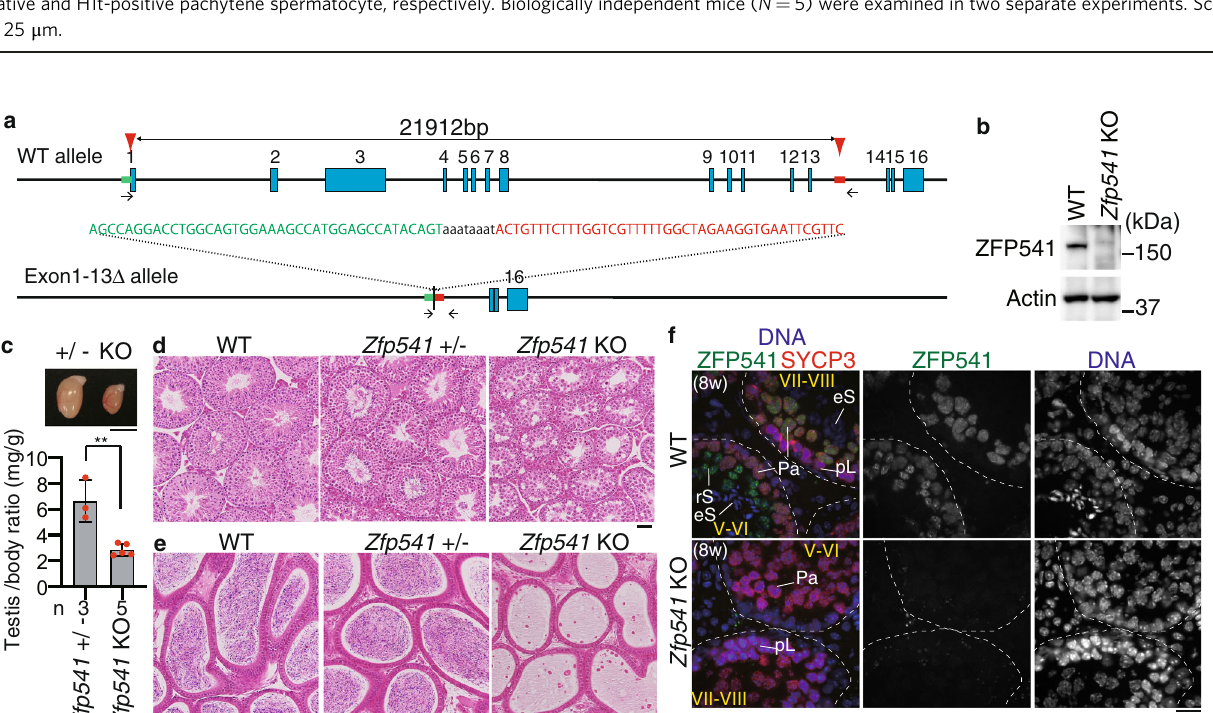
Fig. 2 Spermatogenesis was impaired in Zfp541 knockout male. a The allele with targeted deletion of Exon1 – 13 in Zfp541 gene was generated by the introduction of CAS9, the synthetic gRNAs designed to target Exon1 and the downstream of Exon13 (arrowheads), and ssODN into C57BL/6 fertilized eggs. Arrows: PCR primers for genotyping. Four lines of KO mice were established. Line #16 of Zfp541 KO mice was used in most of the experiments, unless otherwise stated. b Immunoblot analysis of testis extracts prepared from mice with the indicated genotypes (P21). Biologically independent mice ( N = 2) were examined in two separate experiments. c Testes from Zfp541 ± and Zfp541 KO (8-weeks old). Testis/body-weight ratio (mg/g) of Zfp541 ± and Zfp541 KO mice (8-weeks old) is shown below (mean with SD). n : the number of animals examined. Statistical signi fi cance is shown by ** p = 0.0021 (two-tailed t -test). Scale bar: 5 mm. d Hematoxylin and eosin staining of the sections from WT, Zfp541 ±, and Zfp541 KO testes (8-weeks old). Biologically independent mice ( N = 3) for each genotype were examined. Scale bar: 50 μ m. e Hematoxylin and eosin staining of the sections from WT, Zfp541 ±, and Zfp541 KO epididymis (8-weeks old). Biologically independent mice ( N = 3) for each genotype were examined. Scale bar: 50 μ m. f Seminiferous tubule sections (8-weeks old) were stained for SYCP3, ZFP541, and DAPI. pL: preleptotene, Pa: pachytene spermatocyte, rS: round spermatid, eS: elongated spermatid. Boundaries of the seminiferous tubules are indicated by white dashed lines. Roman numbers indicate the seminiferous tubule stages. Biologically independent mice ( N = 3) for each genotype were examined. Scale bars: 15 μ Zfp541 KO seminiferous tubules (Fig. 2d, f). Accordingly, sperm was absent in Zfp541 KO caudal epididymis (Fig. 2e). Con- sistently, seminiferous tubules that contain PNA lectin (a mar- ker of spermatids)-positive cells were absent in Zfp541 KO (Supplementary Fig. 4a, b). Thus, the later stage of spermato- genesis was severely abolished in Zfp541 KO seminiferous tubules, resulting in male infertility. In contrast to male, Zfp541 KO females exhibited seemingly normal fertility with no apparent defects in adult ovaries (Supplementary Fig. 3c, d). Therefore, these results suggested that the requirement of ZFP541 is sexually different.